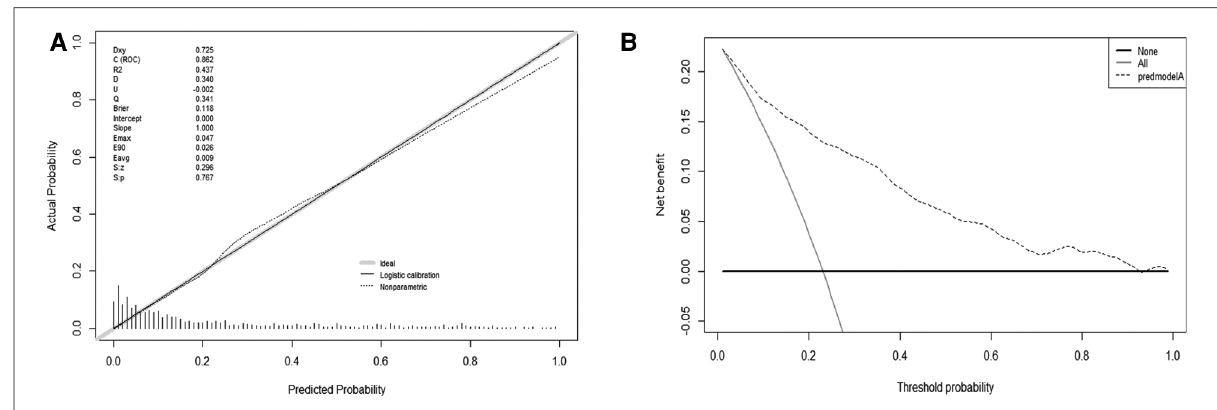
FIGURE 3 ROC curves for validating the discrimination power of the nomogram prediction model. (training group AUC=0.862, validation group